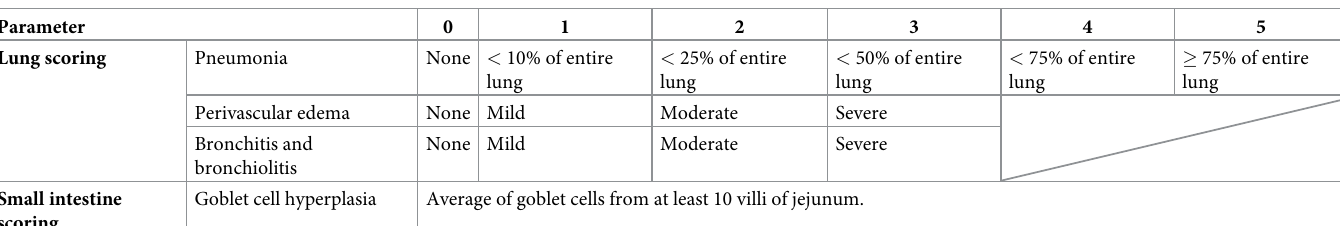
Table 2. Histopathological scoring for quantify the states of the lung and small intestine.